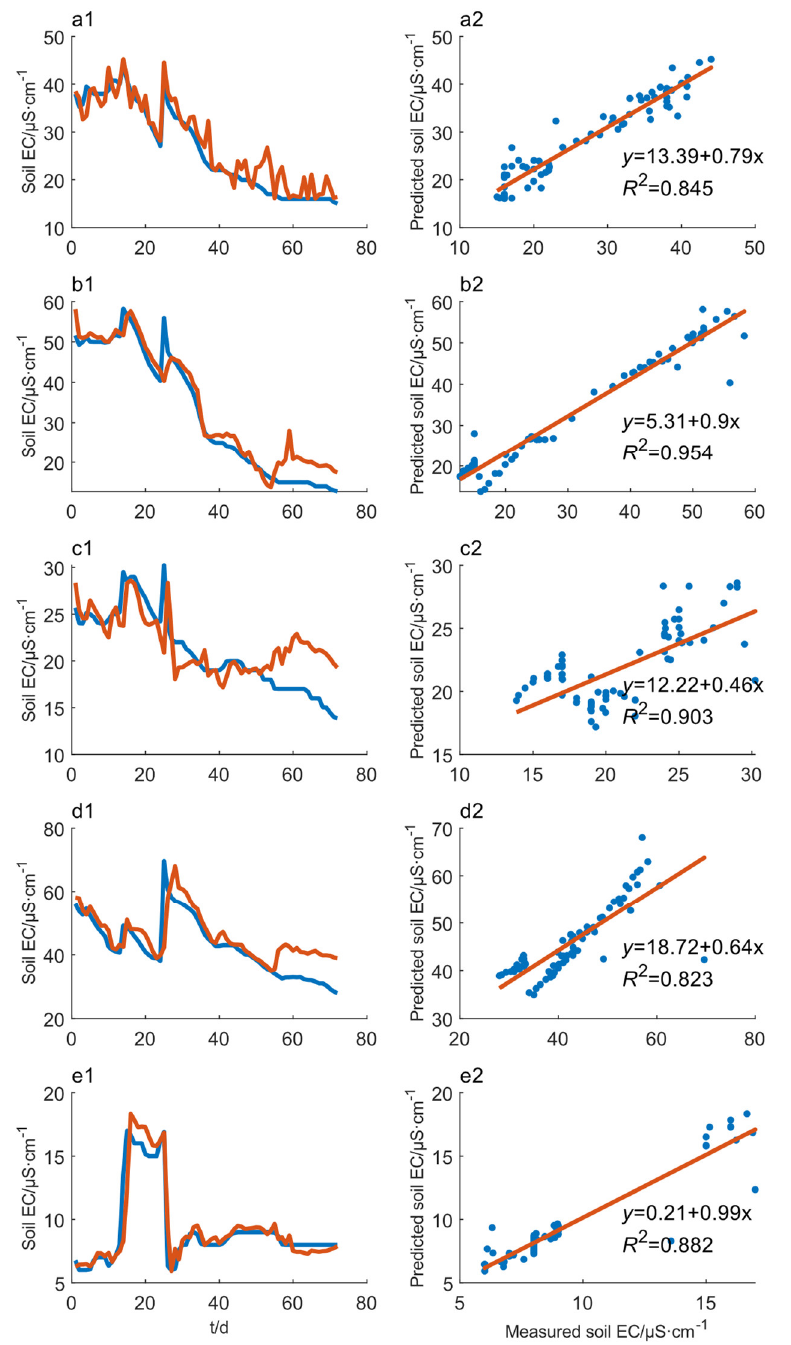
Figure 14. Comparison of the Bid-LSTM model in different datasets for SEC. ( a – e ) represent node 1–5, respectively; in ( a1 – e1 ), the blue line represents the measured SEC, and the orange line represents the predicted SEC; ( a2 – e2 ) represents the regression fitting between the predicted SEC and measured SEC.